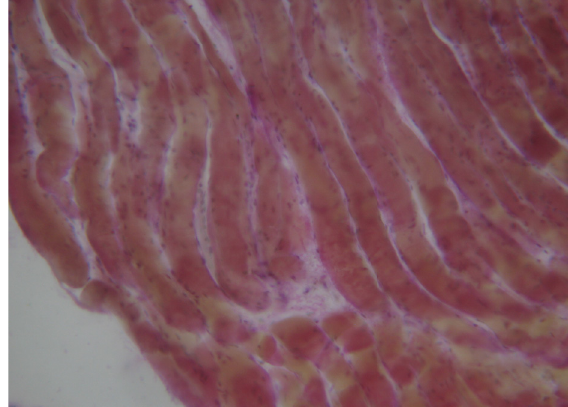
Figure 3. Microstructure of a lip tissue sample after processing with the ferment preparation Protepsin, magn. 200. (after 1 hour).